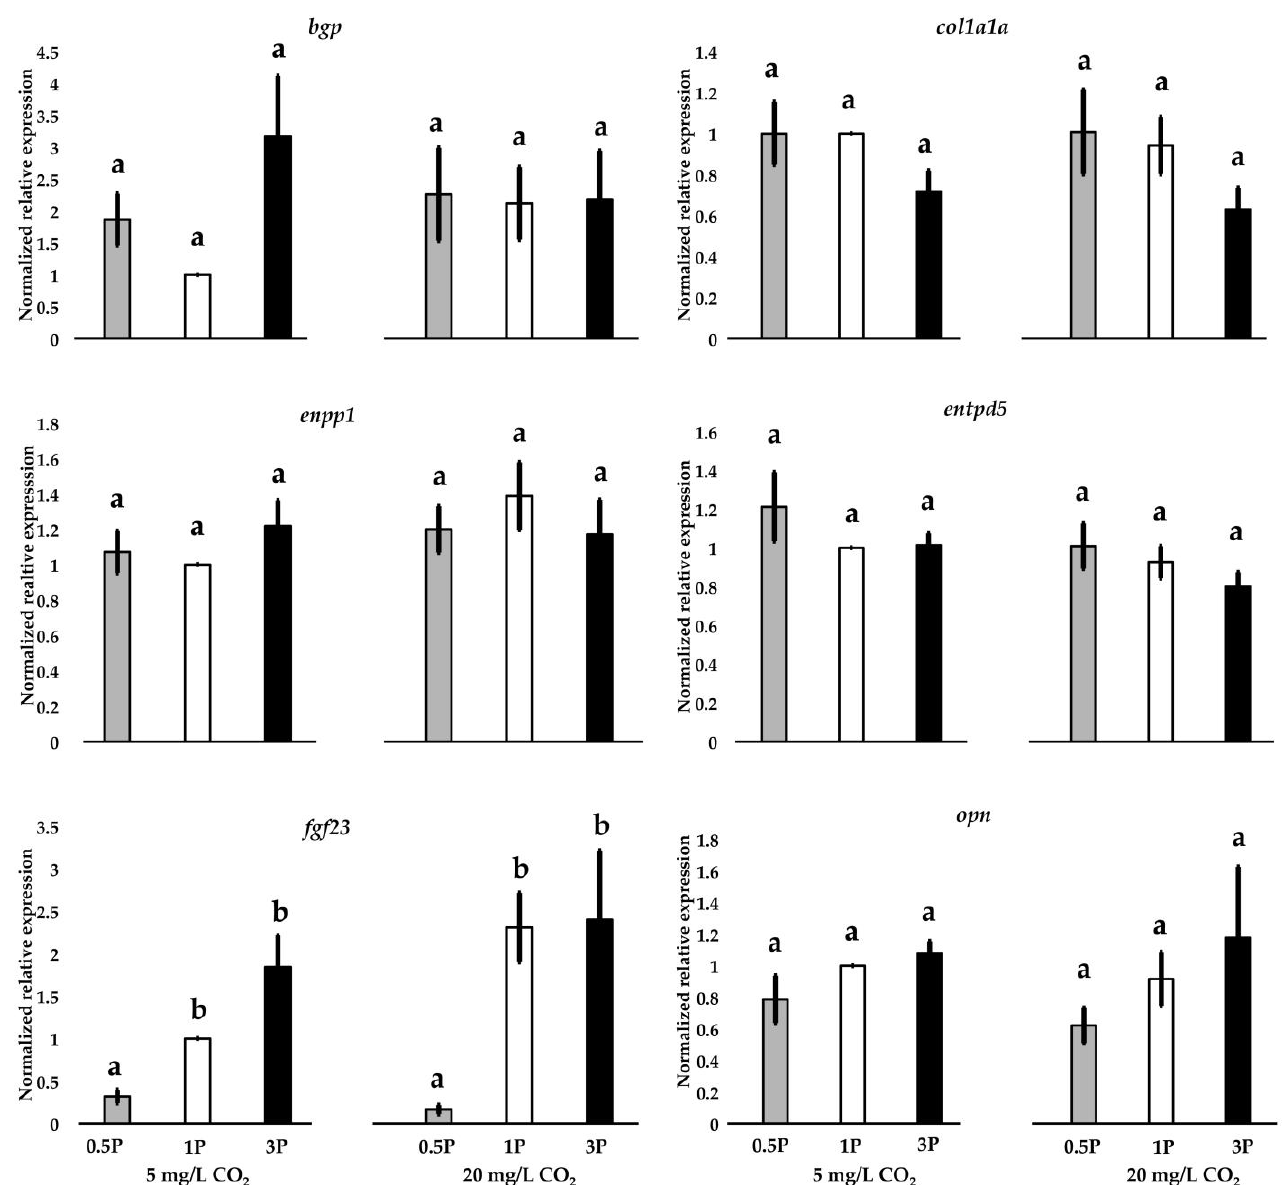
Figure 8. Gene expression. Quantitative PCR of gene expression in the vertebral centra of animals fed different levels of total phosphorus (P) 0.5P (6.3 g/kg), 1P (9.0 g/kg), and 3P (26.8 g/kg) and reared in conditions with no CO 2 injected (5 mg/L) or with injected CO 2 (20 mg/L). Graphs show expression of bgp (bone gla protein), col1a1a (collagen type 1 alpha 1a), enpp1 (endonucleotide pyrophosphatase/phosphodiesterase 1), entpd5 (ectonucloside triphosphate disphosphohydrolase 5), fgf23 (fibroblast growth factor 23), and opn (osteopontin). fgf23 expression levels were significantly downregulated in 0.5P/5CO 2 animals compared with the other groups. Results are expressed as mean +/− standard error. Different letters denote significant differences among the groups.